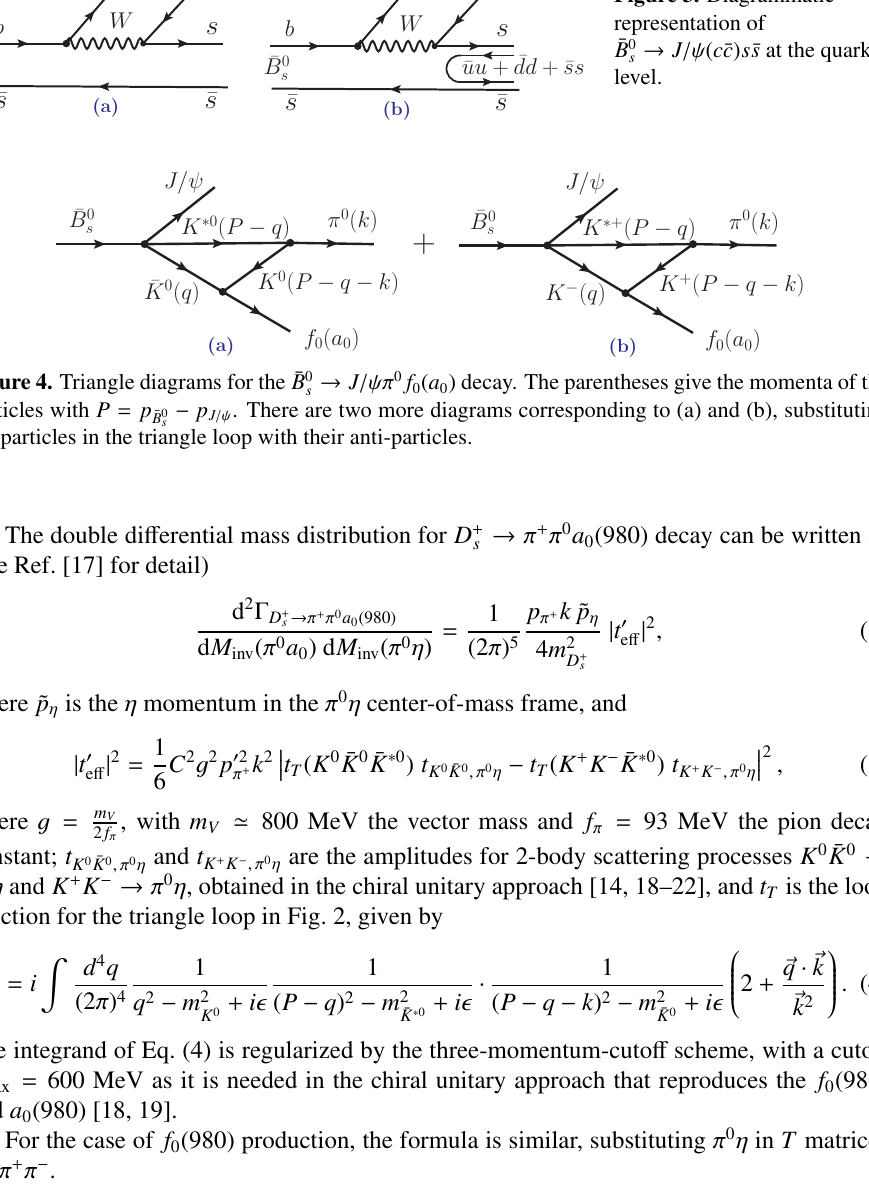
Figure 3. Diagrammatic representation of → J /ψ ( c ¯ c ) s ¯ s at the quark ¯ B 0 s level.